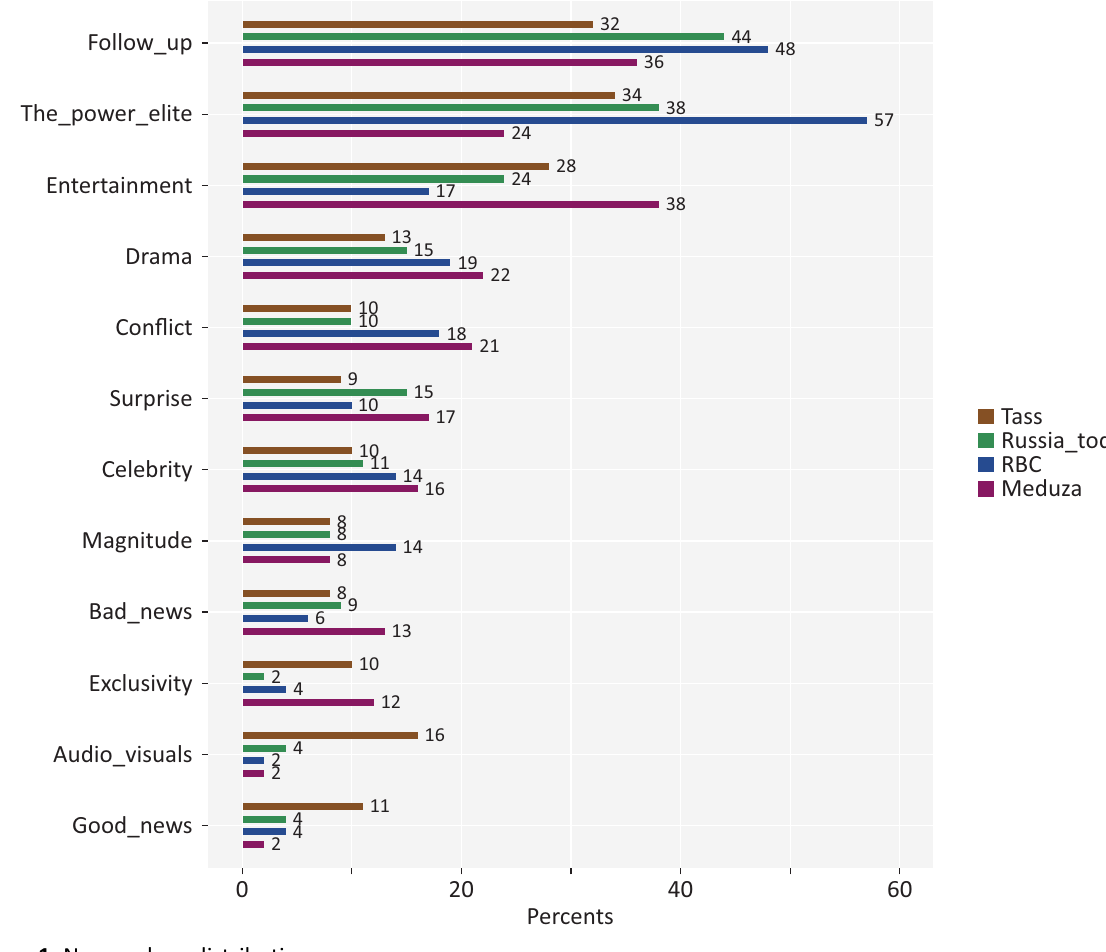
Figure 1. News values